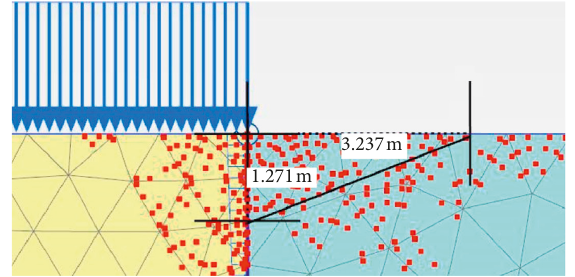
Figure 16: Distribution of failure points inside the foundation pit at φ � 40 °